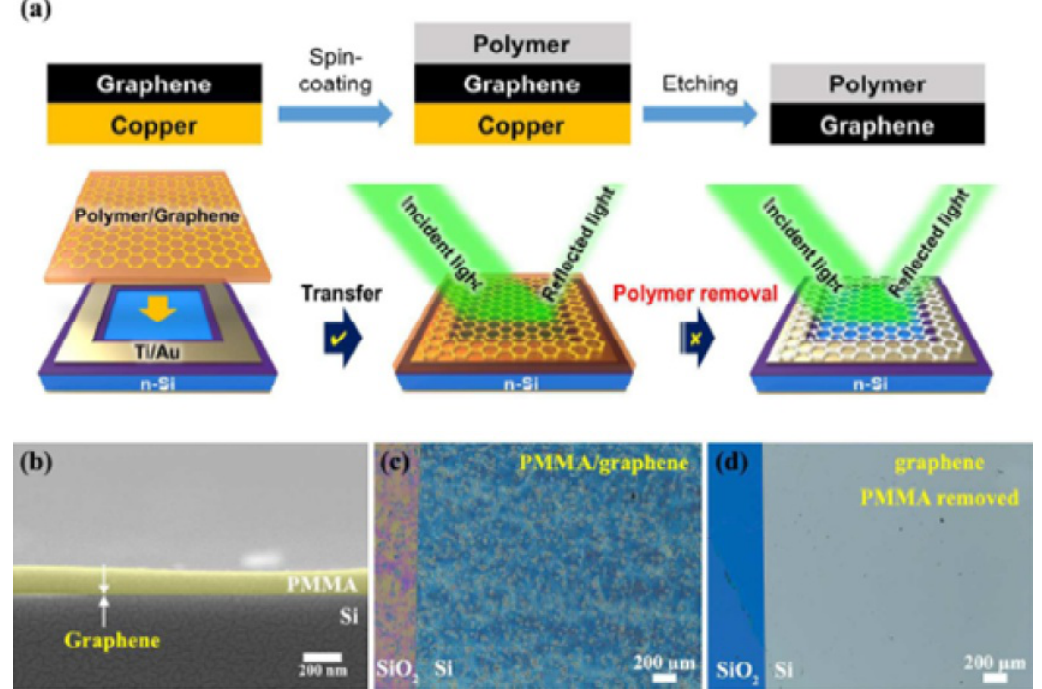
Fig. 1 . (a) Schematic view of polymer-coated G/Si solar cells fabrication. (The copper substrate underneath the graphene film was etched away in FeCl /HCl solution) (b) The cross section of G/Si with PMMA coating 3 from Scanning electron microscope (SEM) of (2000 rpm, M  50,000 mol g –ª , 4 wt.% in ethyl lactate). w False colour (yellow) is applied on PMMA layer. Cracks on the surface of Si were caused by inhomogene- ous deposition of Au coatings, which are necessary for the SEM characterization of PMMA layers. Optical microscope images of G/Si solar cells (c) with PMMA coating (2000 rpm) (d) without PMMA layers. Re- printed with permission from X. Gan, R. Lv, H. Zhu, L. P. Ma, X. Wang and Z. Zhang // Journal of